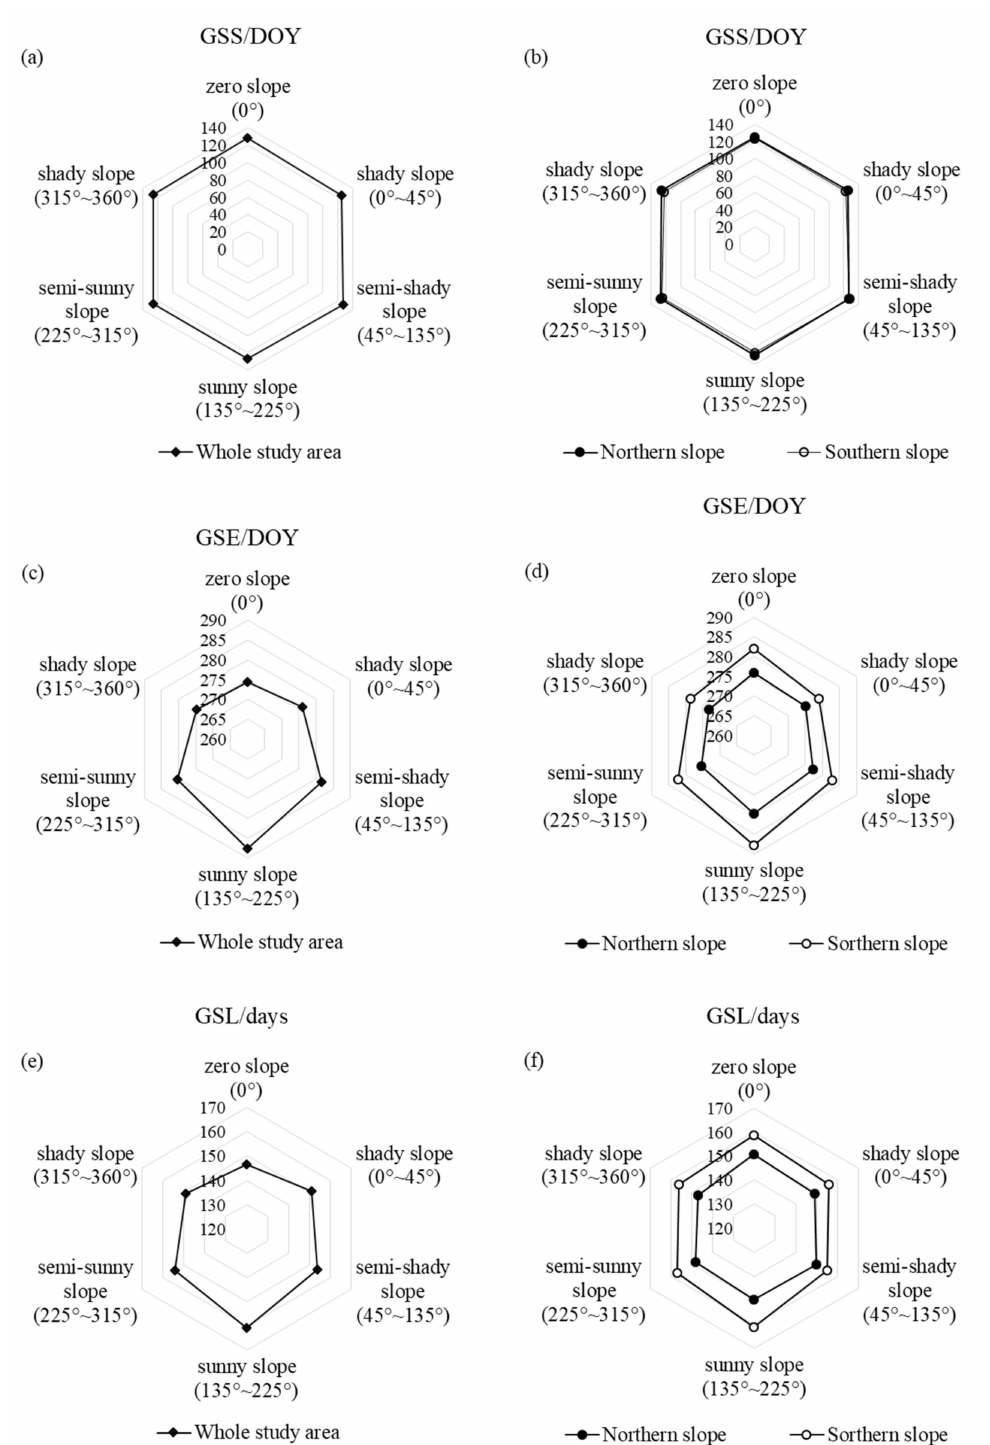
Figure 8. Changes of vegetation phenological parameters on the different aspects in Niubeiliang Reserve from 2000 to 2017. ( a ) GSS of the whole area with the aspect; ( b ) GSS of the northern and southern slopes with the aspect; ( c ) GSE of the whole area with the aspect; ( d ) GSE of the northern and southern slopes with the aspect; ( e ) GSL of the whole area with the aspect; ( f ) GSL of the northern and southern slopes with the